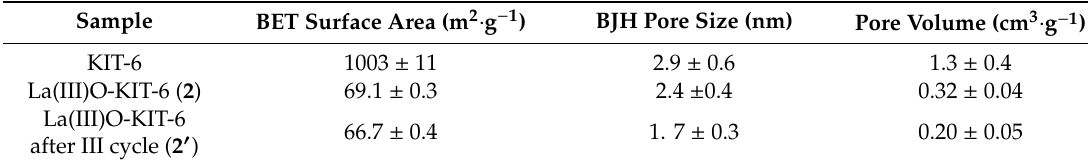
Table 2. The pore structure parameters of the as-prepared mesoporous silica KIT-6 and the catalyst before and after the etherification of glycerol.